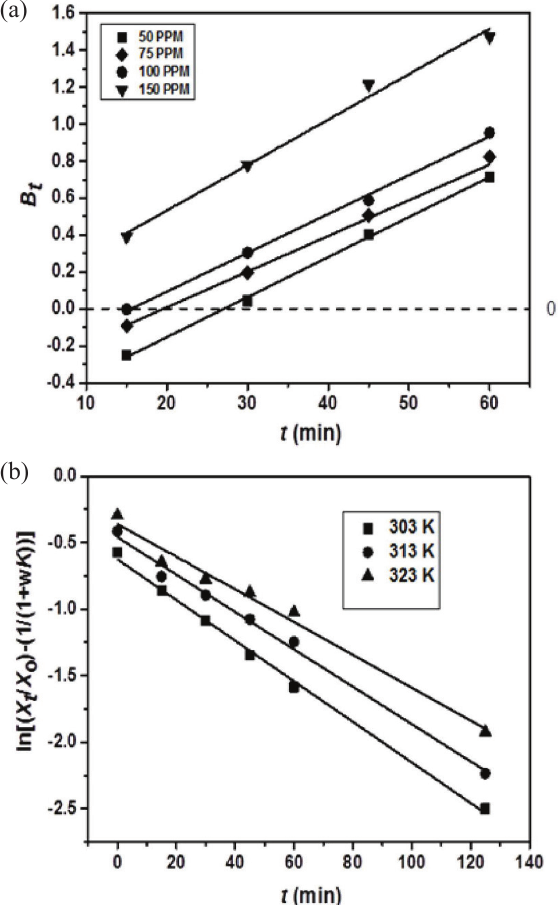
Fig. 6 – (a) Boyd plot for the abatement of 2-CP using RSAC, (b) External mass transfer plot for 2-CP-RSAC sorption sys- tem; with the parametric conditions as (X t = 125 min; w = 1.25 g L –1 ; pH =